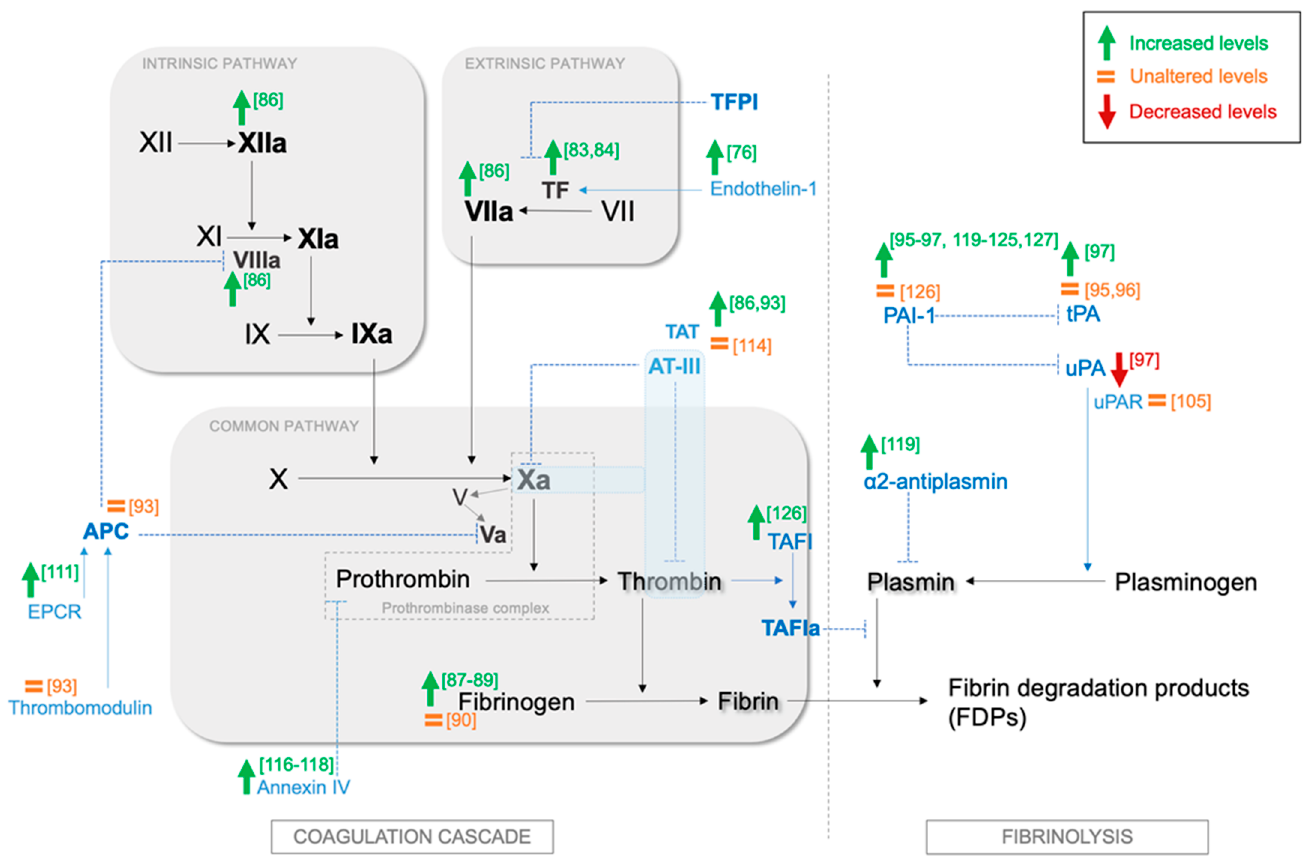
Figure 1. The coagulation cascade and fibrinolysis and how obstructive sleep apnoea (OSA) interacts with them. APC— activated protein C; AT-III—antithrombin III; EPCR—endothelial protein C receptor; IX—factor IX; IXa—activated factor IX; PAI-1—plasminogen activator inhibitor-1; TAFI—thrombin activated fibrinolysis inhibitor; TAFIa—activated thrombin activated fibrinolysis inhibitor; TAT—thrombin-antithrombin complex; TF—tissue factor; TFPI—tissue factor pathway inhibitor; tPA—tissue plasminogen activator; uPA—urokinase plasminogen activator; uPAR—urokinase type plasminogen activator receptor; Va—activated factor V; VIIIa—activated factor VIII; X—factor X; Xa—activated factor X; XI—factor XI; Xia—activated factor XI; XII—Factor XII; XIIa—activated factor XII.